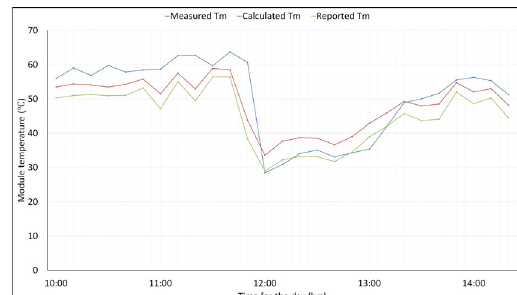
Figure 3. Module temperature graph for clear sky day 12 th Oct of a-Si PV